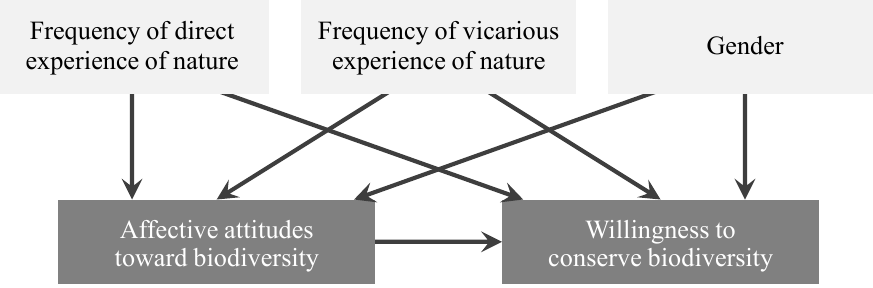
Figure 1. Hypothesized framework illustrating relationships between children’s experience of nature and their affective attitudes toward and willingness to conserve biodiversity. In this study, affective attitude toward biodiversity was used as a mediating factor between experience of nature and willingness to conserve biodiversity. Gender was included to control for its potential confounding effects on children’s attitudes toward and willingness to conserve biodiversity.